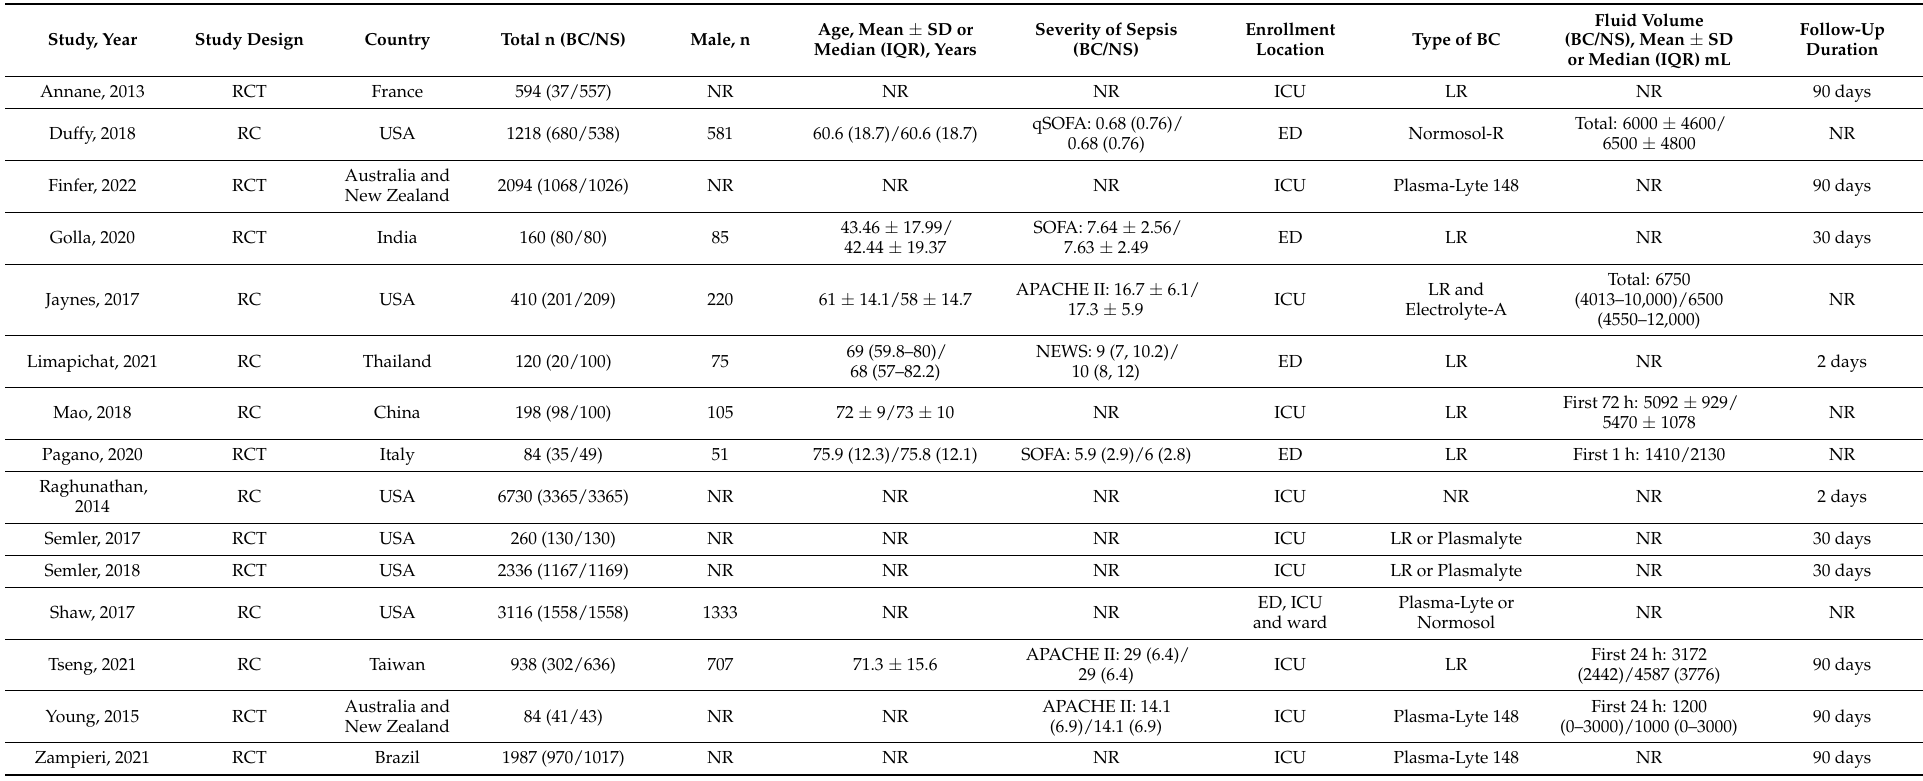
Table 1. Study and patient characteristics of the included